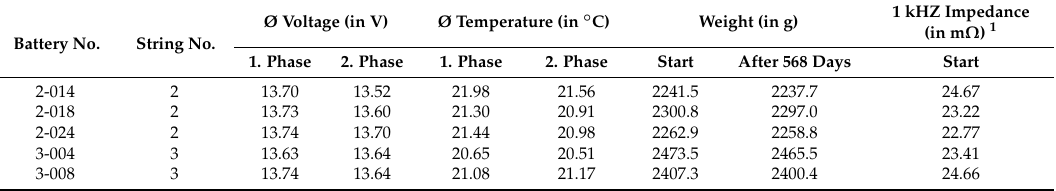
Table 3. Main characteristic of the batteries used for regular check-up measurements.